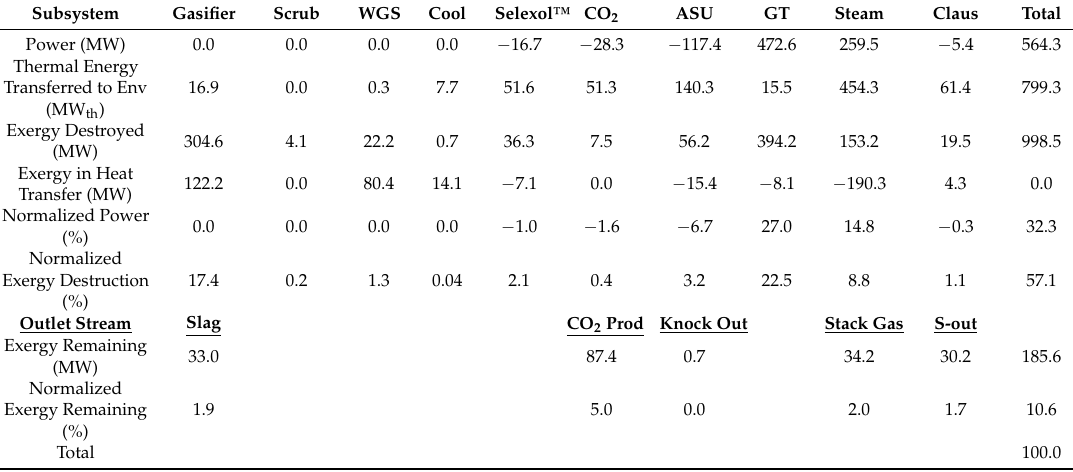
Table 5. Baseline Model Results, assigning all exergy destruction associated with heat transfer between subsystems to the Steam